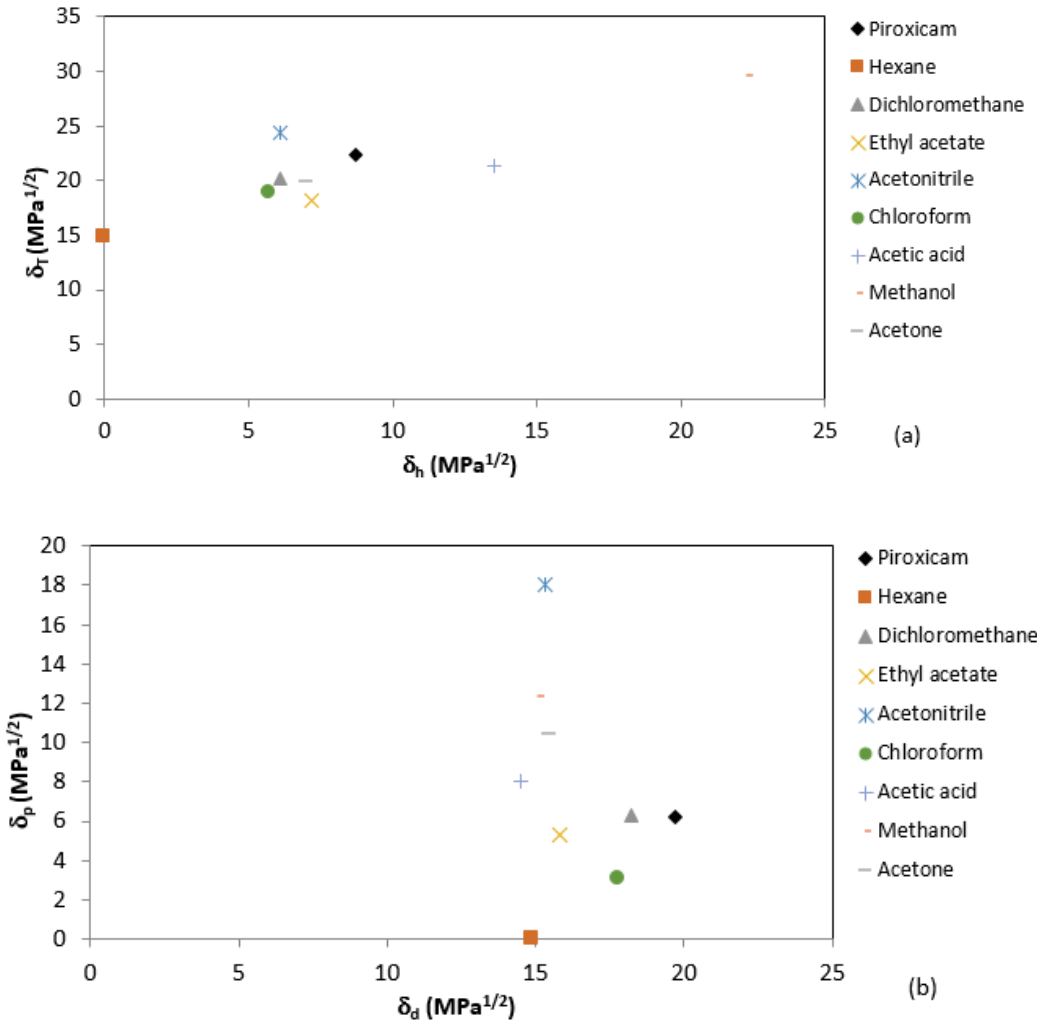
Figure 2. (2-column fitting) Hansen solubility parameters for piroxicam and solvents. ( a ) δ T versus δ H ; ( b ) δ p versus δ d (Hansen solubility parameters for solvents and piroxicam are found in [17] and [18], respectively).